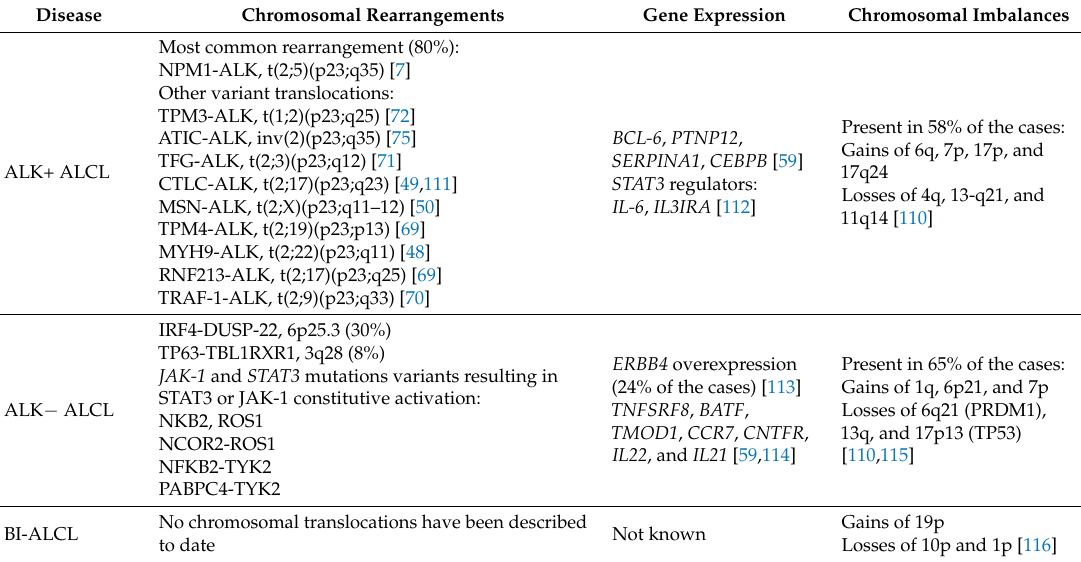
Table 3. Genetic and molecular findings in